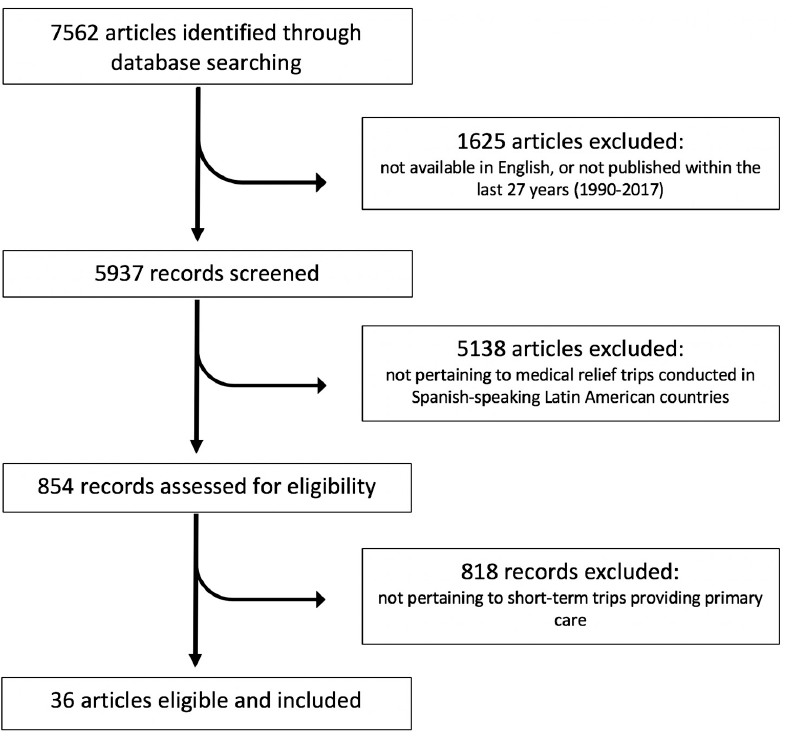
Figure 1. Selection of eligible articles included in literature review to identify best practices in organizations that serve Spanish-speaking countries in Latin America.